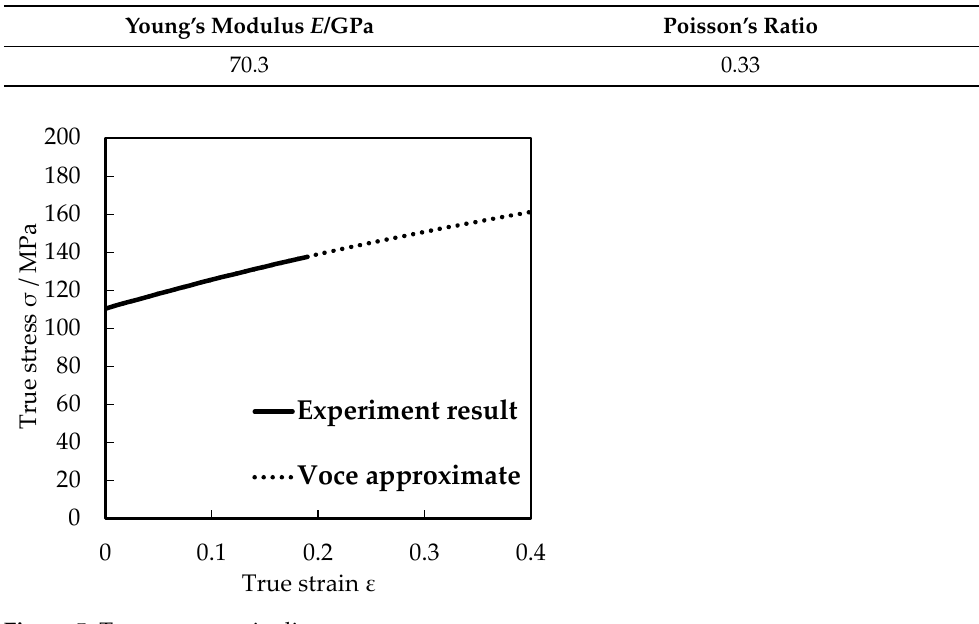
Figure 5. True stress–strain diagram. Table 4. Value of the parameters in Voce